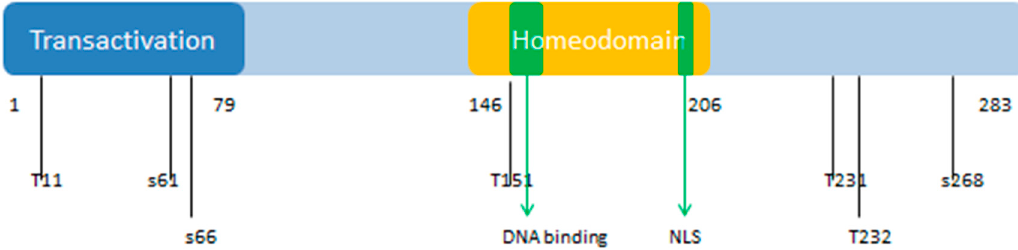
Figure 10. Functional domains and phosphorylation sites of human Pancreatic and Duodenal Homeobox 1 Protein (PDX1). The numbers indicate the positions of phosphorylation sites and functional domains on the polypeptide chain of human PDX1. PTD: Protein transduction domain; S: